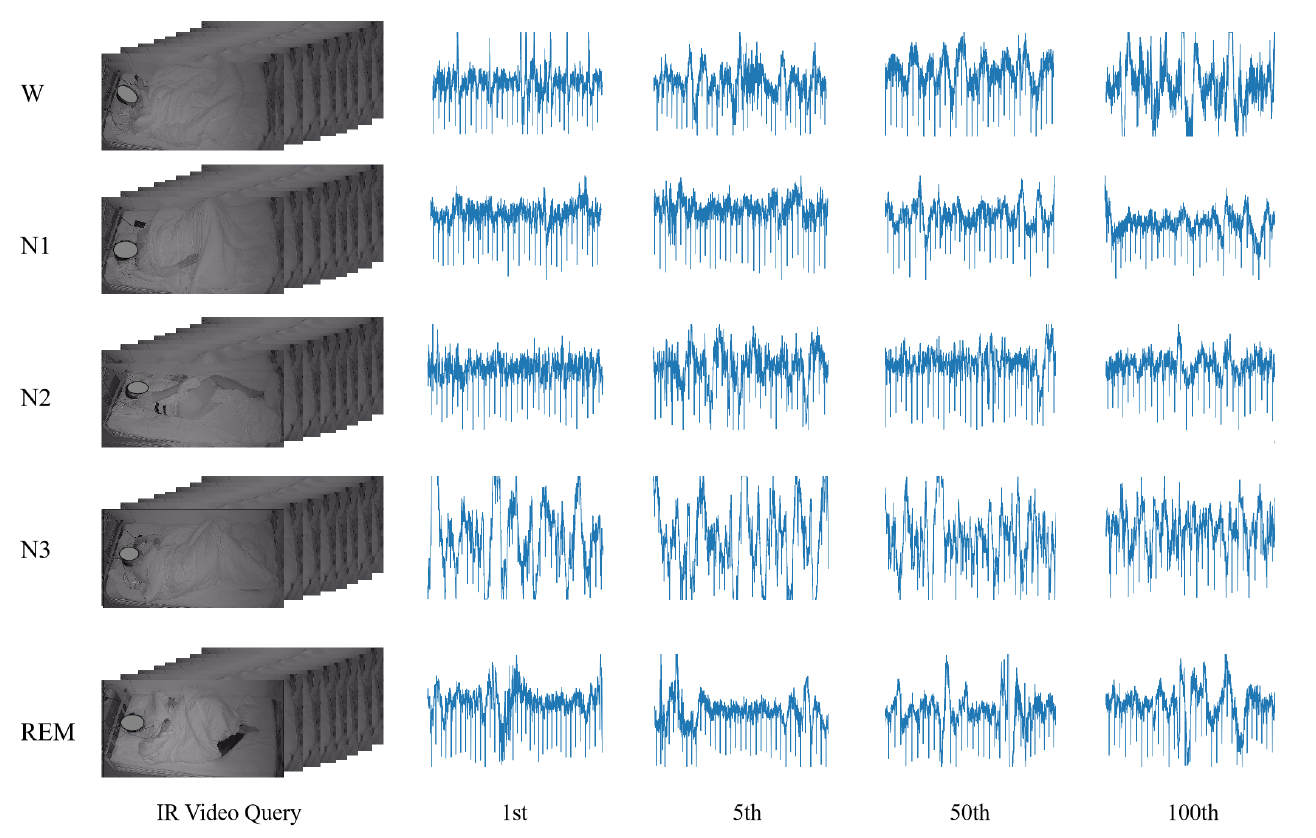
Figure 6. IR video → EEG retrieval results obtained when hash code length is 64 for S 3 VE dataset [60]. Regarding the EEG, we show the raw signal output by the PSG device, with some artifacts and